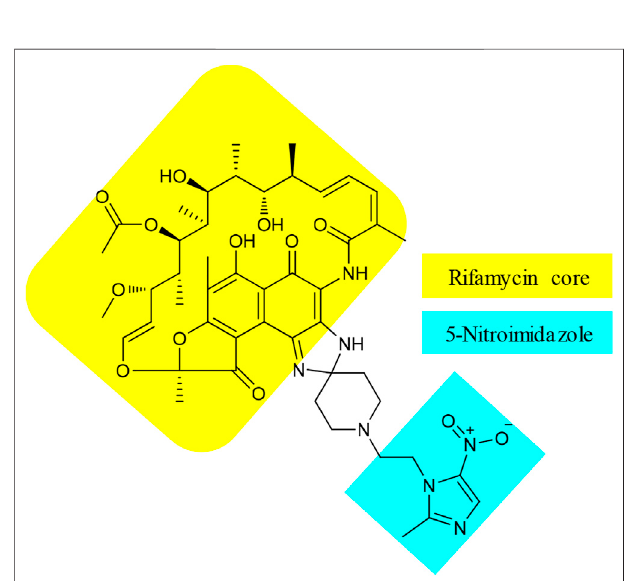
FIGURE 5 | Chemical structure of TNP-2198 ( 22